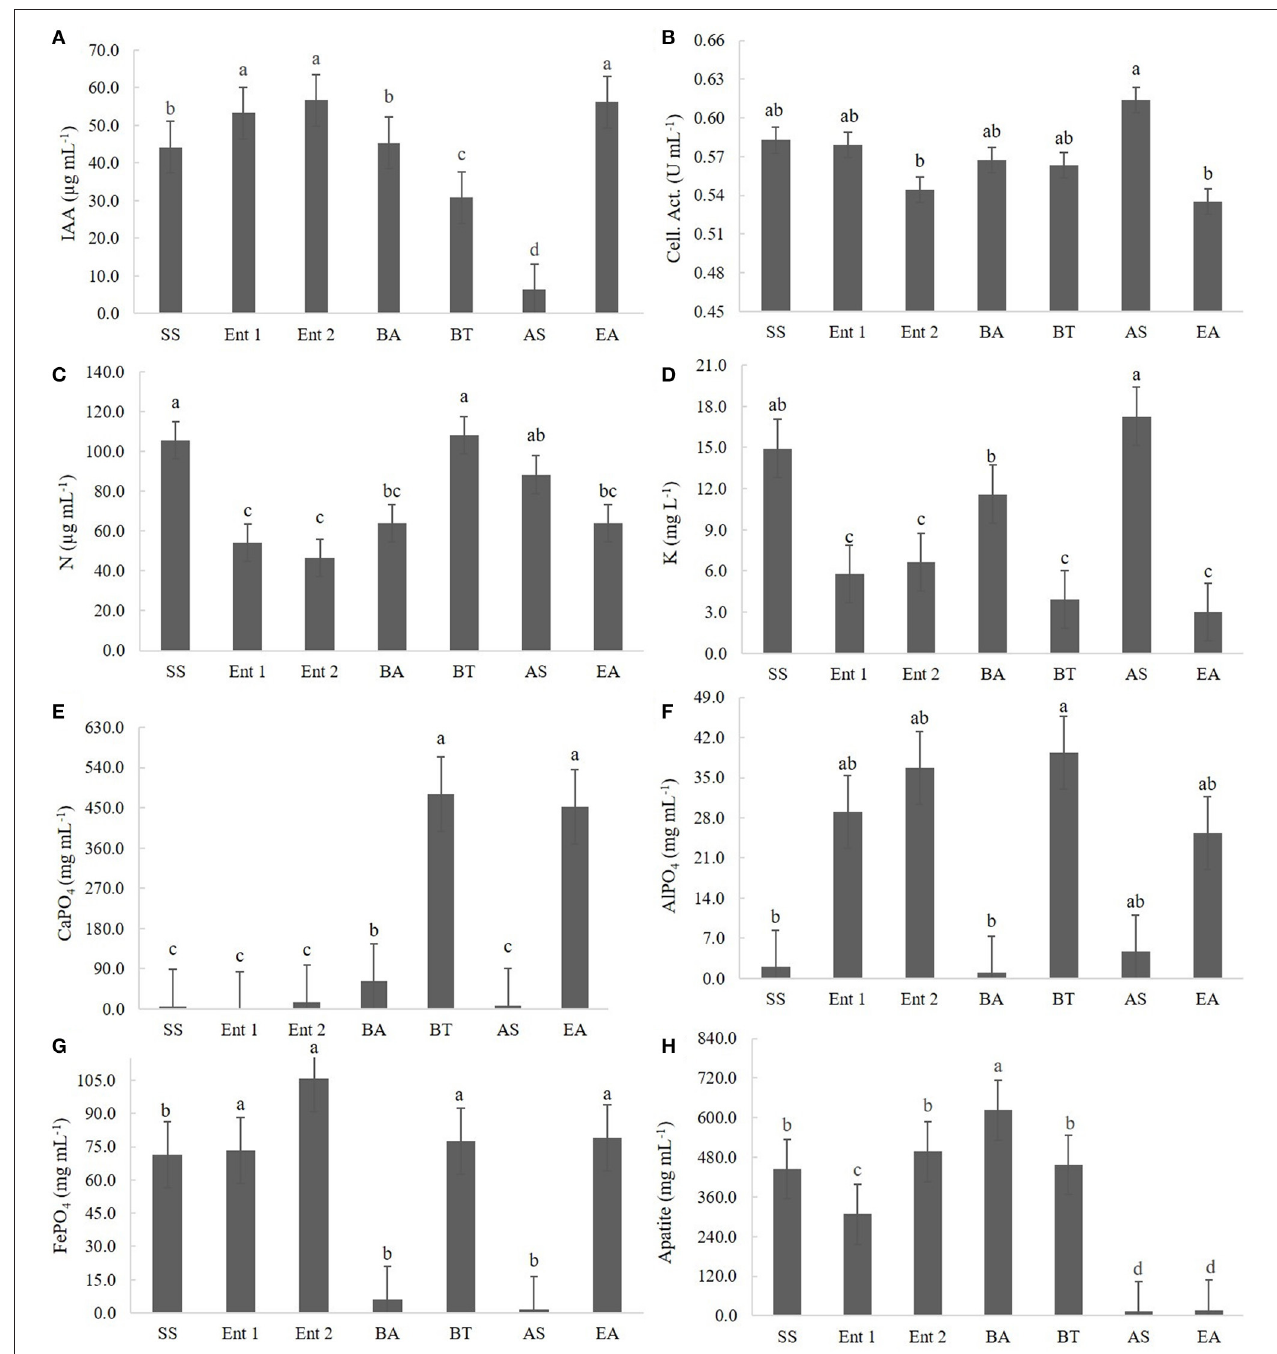
FIGURE 2 | Quantitative results for (A) IAA production, (B) cellulolytic activity, (C) BNF, (D) K solubilization, (E) CaPO 4 solubilization, (F) AlPO 4 solubilization, (G) FePO 4 solubilization, and (H) Araxá apatite solubilization. Means followed by the same letters do not differ according to Tukey’s test at 5% probability. SS, S. saprophyticus IJ8; Ent 1, Enterobacter sp. IP11; Ent 2, Enterobacter sp. IP14; BA, B. anthracis IP17; BT, B. thuringiensis IP21; AS, A. spanius IP23; EA, E. asburiae IP24; Control, no